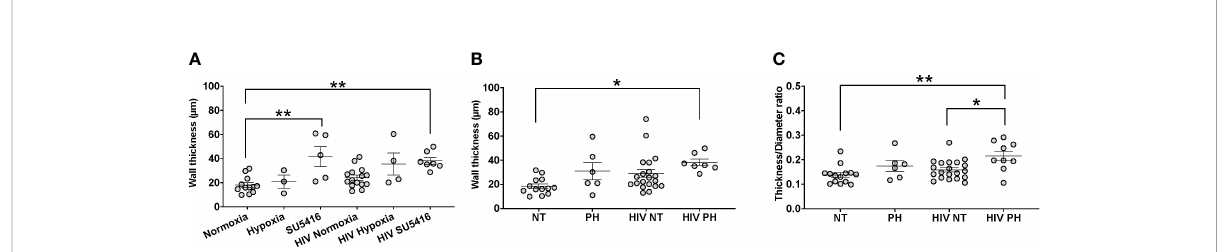
FIGURE 4 Analyses of tunica media thickness in humanized mice. The thickness of the tunica media and vessel diameter were measured using hematoxylin-stained lung tissue images. (A) The wall thickness data analyzed by hit (hypoxia, SU5416, or HIV); (B) The wall thickness of different mice models normotensive or pulmonary hypertensive and HIV +/-; (C) The ratio of the thickness:diameter comparing different mice models. Each circle represents a vessel in a series of images from different mice (n=2-3 per group). Total number of mice: 22 (7 males and 15 females). Statistical signi fi cance is indicated as follows: *, p<0.05; **, p<0.01. Data are depicted as mean,